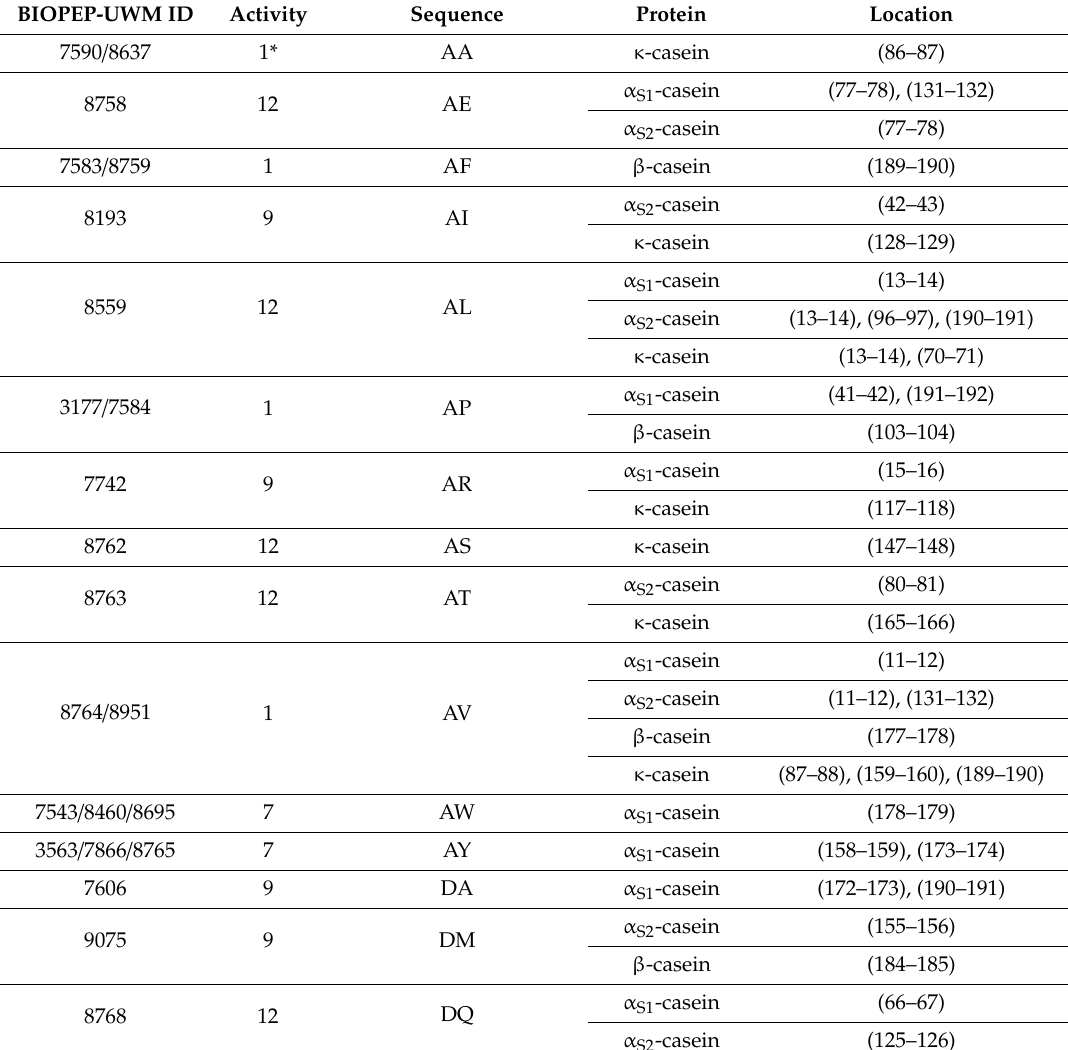
Table A1. Biopeptides (MetS-preventive sequences) Present in the Sequences of Bovine Caseins - Data Acquired from the BIOPEP-UWM Database (accessed on March